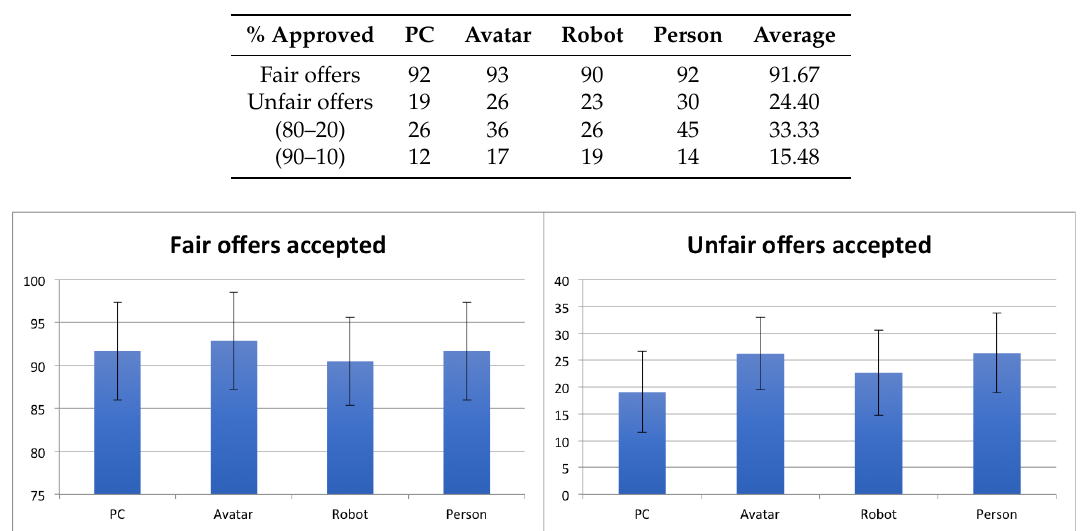
Table 1. Summary of results. Percentage of accepted fair and unfair offers per condition